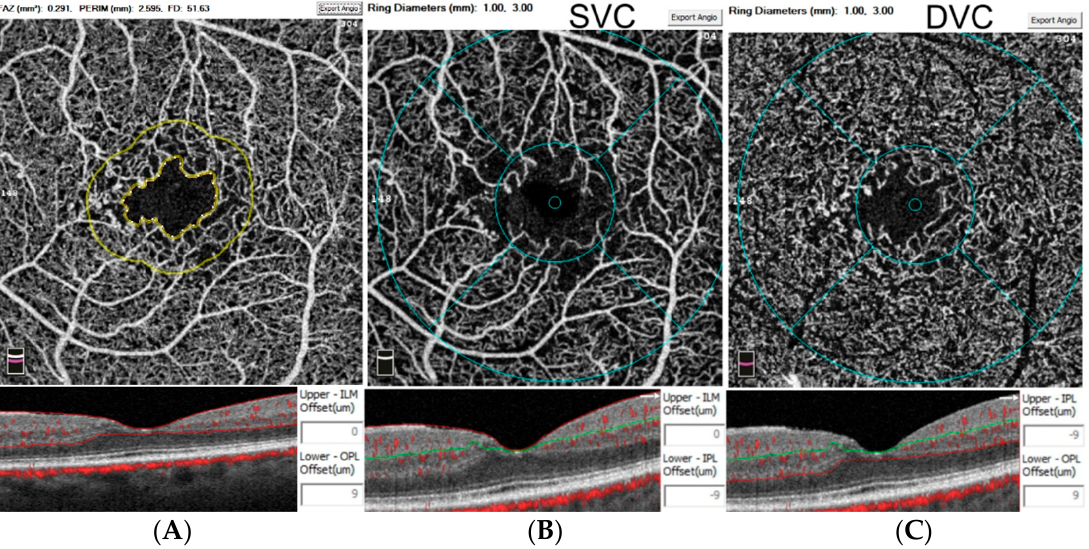
Figure 1. Overview of the measurements on optical coherence tomography angiography. The foveal avascular zone (FAZ) area, perimeter, and parafoveal 300-µm ring vessel density (FD–300) were automatically measured in the slab between the internal limiting membrane (ILM) and 9 µm below the outer plexiform layer (OPL) ( A ). The whole image and parafoveal vessel density were quantified in the superficial vascular complex (SVC) between the ILM and 9 µm above the inner plexiform layer (IPL) ( B ) and the deep vascular complex (DVC) between 9 µm above the IPL and 9 µm below the OPL ( C ).